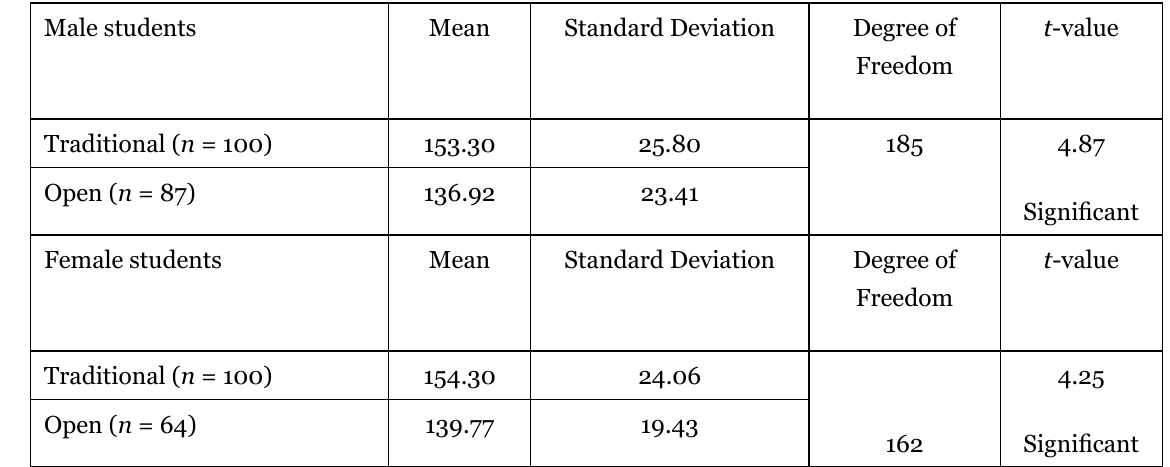
T-Test Analysis for the Comparison of Academic Motivation of Male Students and Female Students Studying in TES and